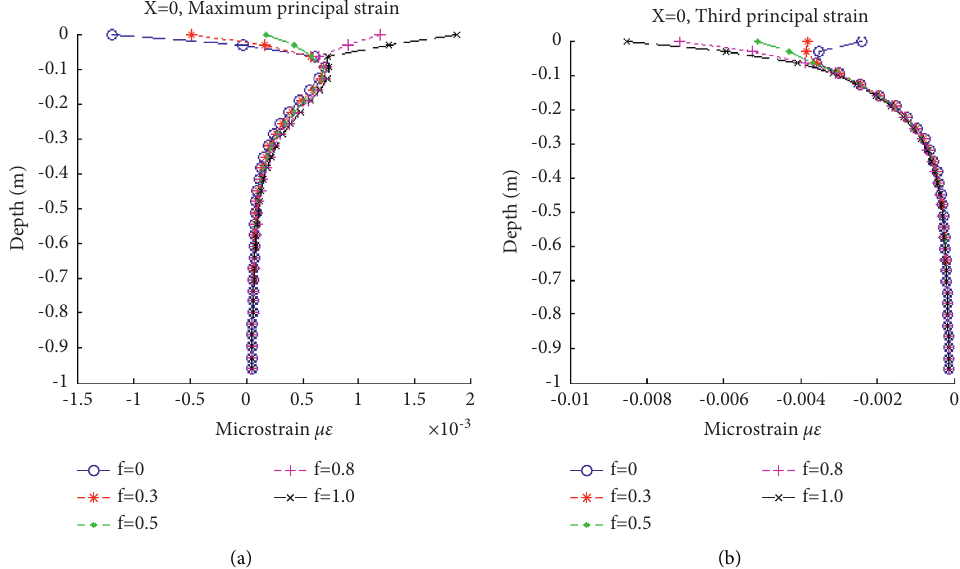
Figure 15: Calculation results of principal strain of z -axis ( x � 0) at center point of single circular load. (a) Calculation results of maximum principal strain of z -axis ( x � 0) at center point of single circular load. (b) Calculation results of third principal strain of z -axis ( x � 0) at center point of single circular